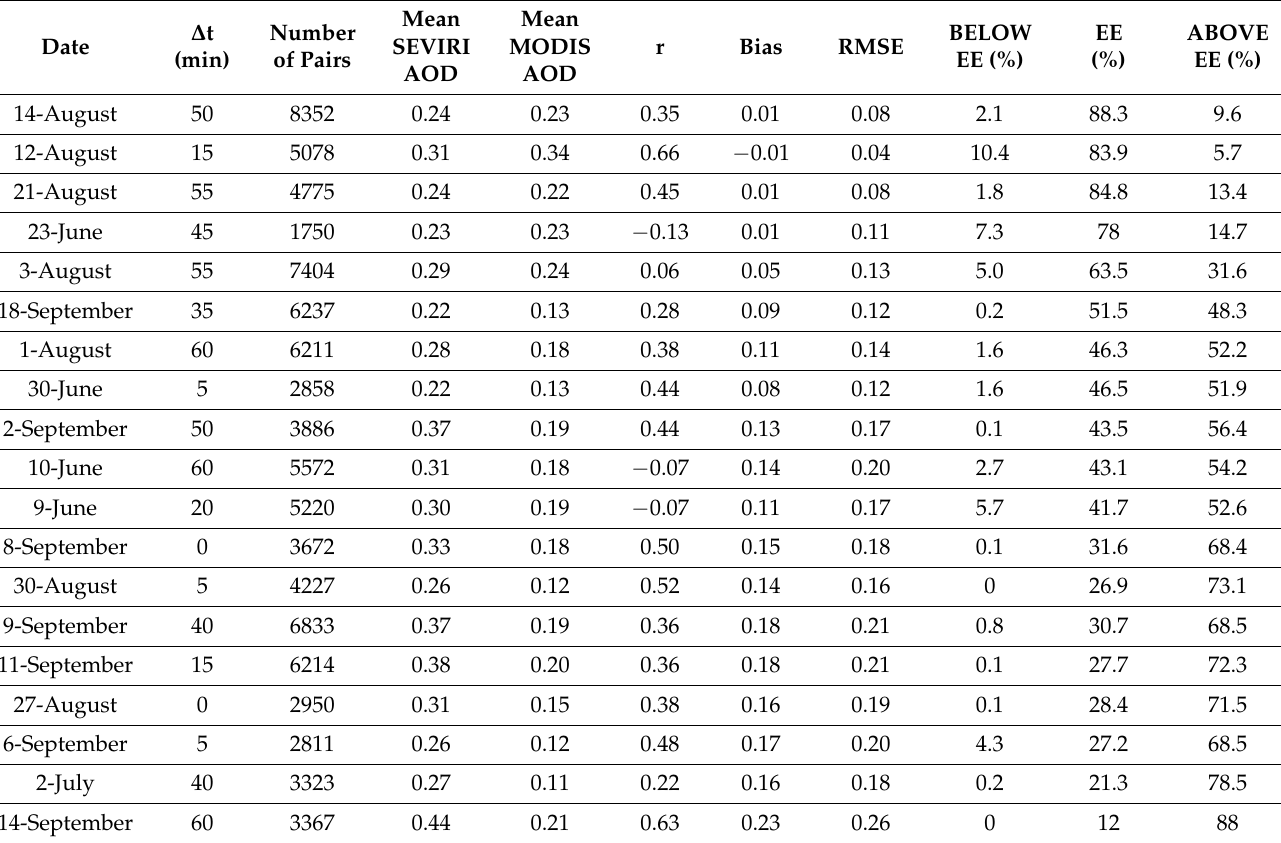
Table 5. Statistics: SEVIRI AOD vs. MODIS